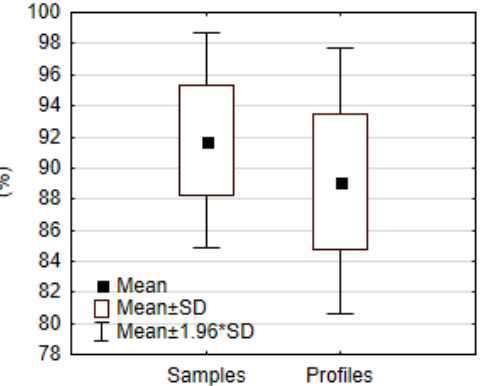
Figure 7. Sand content in the samples and in the literature profiles (*—refers to the multiplication sign).